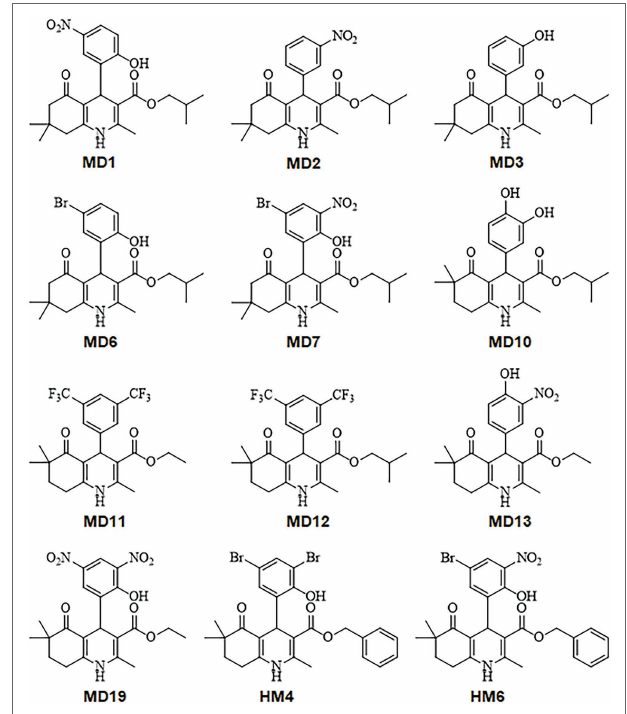
FIGURE 1 | Chemical structures of the 1,4-dihydropyridine (DHP)-based hexahydroquinoline (HHQ) derivatives evaluated in this work.